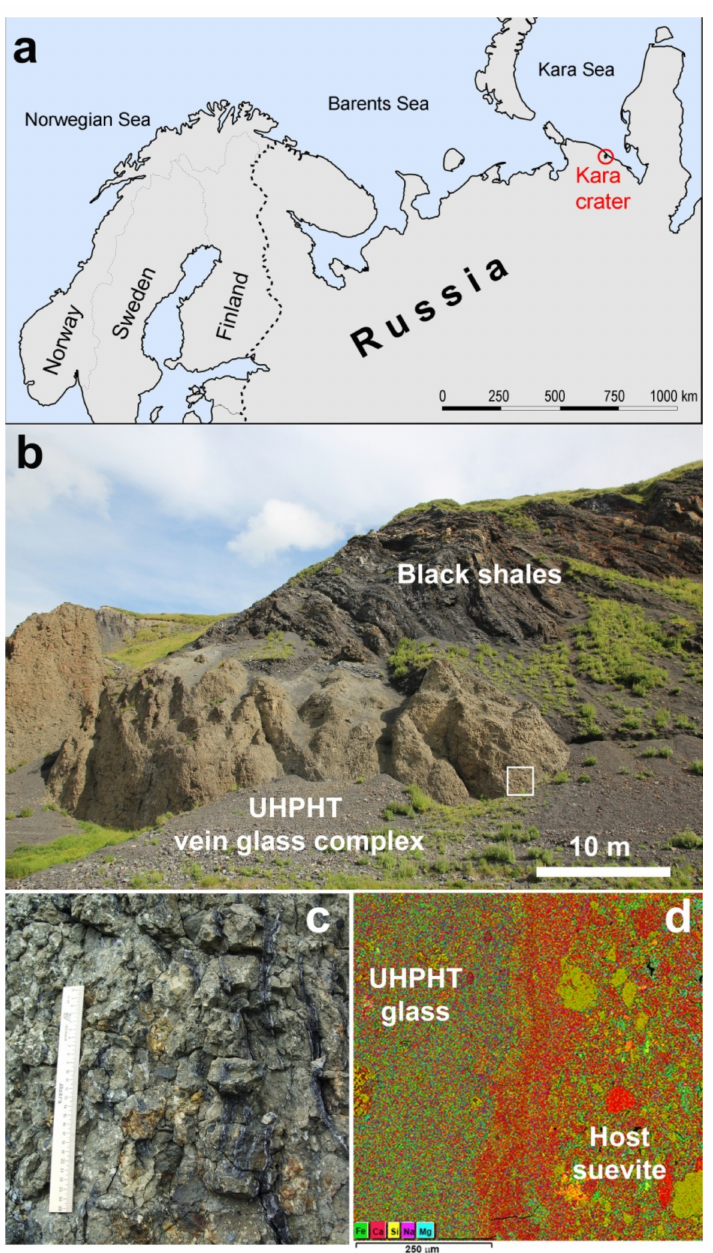
Figure 1. The Kara UHPHT vein glasses: ( a )—geographic position of the Kara crater; ( b )—sampled point within the suevite complex (marked by a white square), origin outcrop at the right bank of the Kara river (Pay-Khoy); ( c )—vein glasses position within the host suevite; ( d )—an electron microprobe multicomponent elemental map of the UHPHT glass (left side) with a quenched zone (central vertical zone) in the host